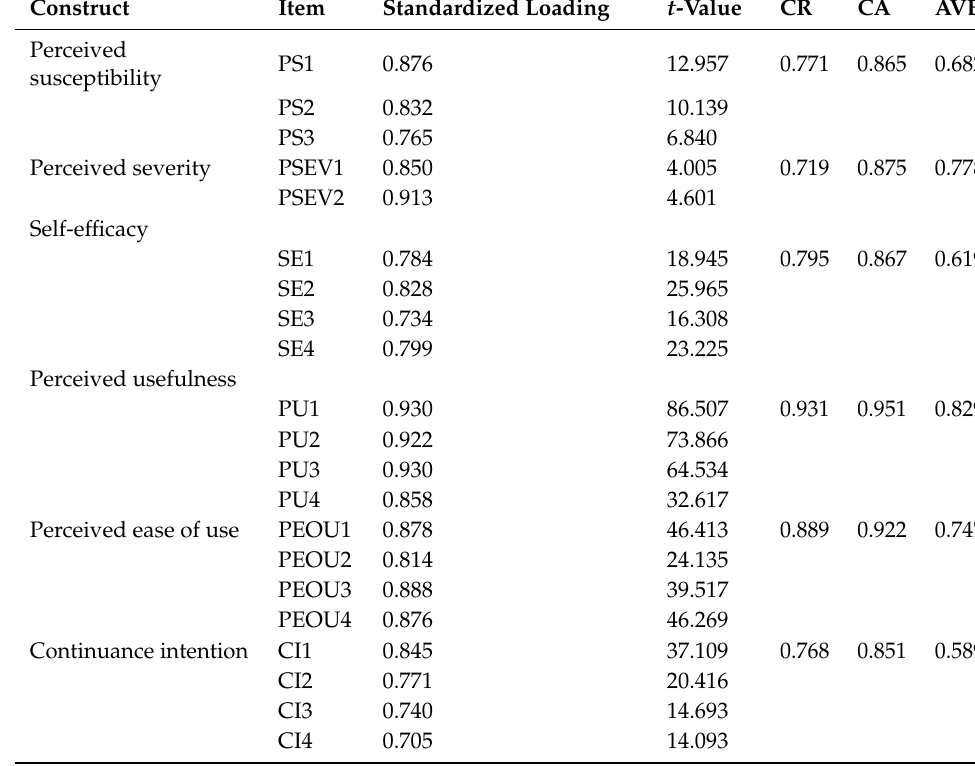
Table 2. Measurement model evaluation: individual item reliability, construct reliability, and conver- gent